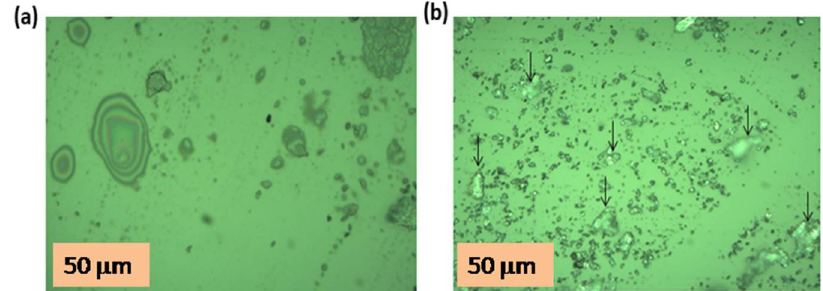
Figure 1. Optical micrographs of ( a ) water-insoluble chitosan (W IS CHT) and ( b ) water-soluble chitosan (W S CHT). The arrows in the image indicate the locations of W S CHT particles.